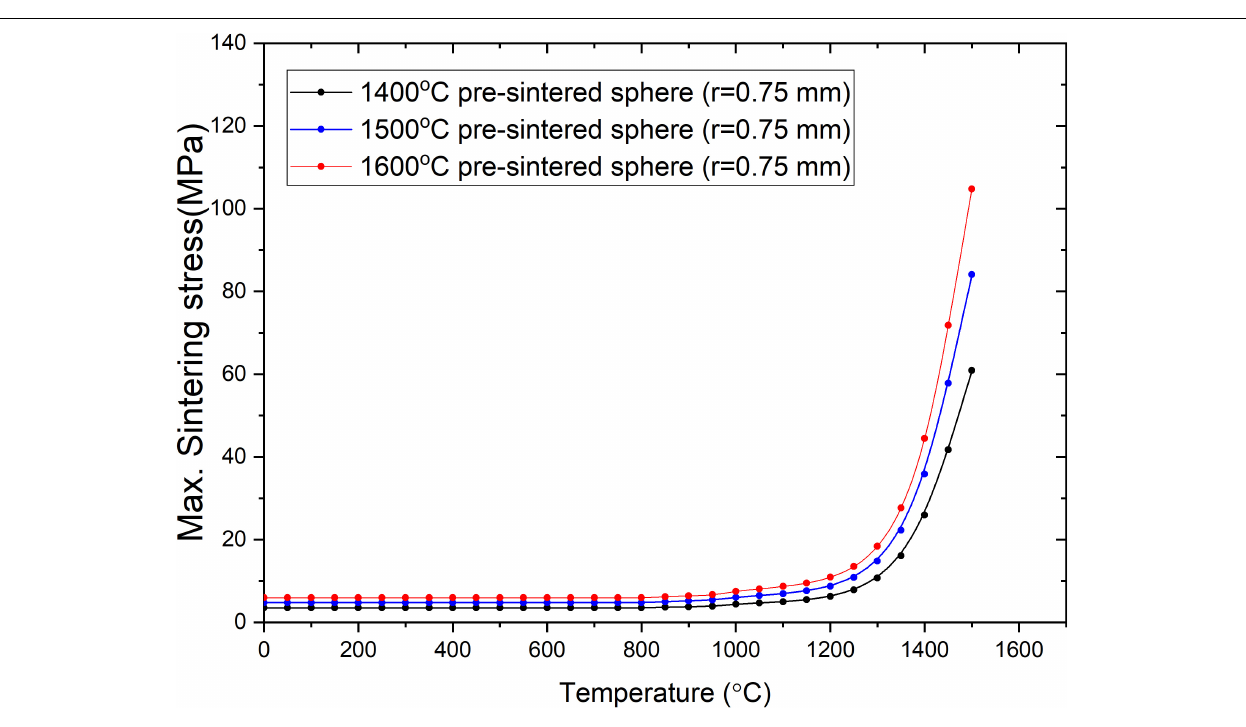
Frontiers in Energy Research |